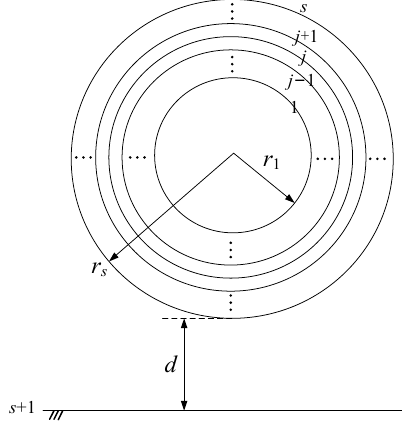
Figure 2. Geometrical configuration of the cross ‐ section of an MWCNT.